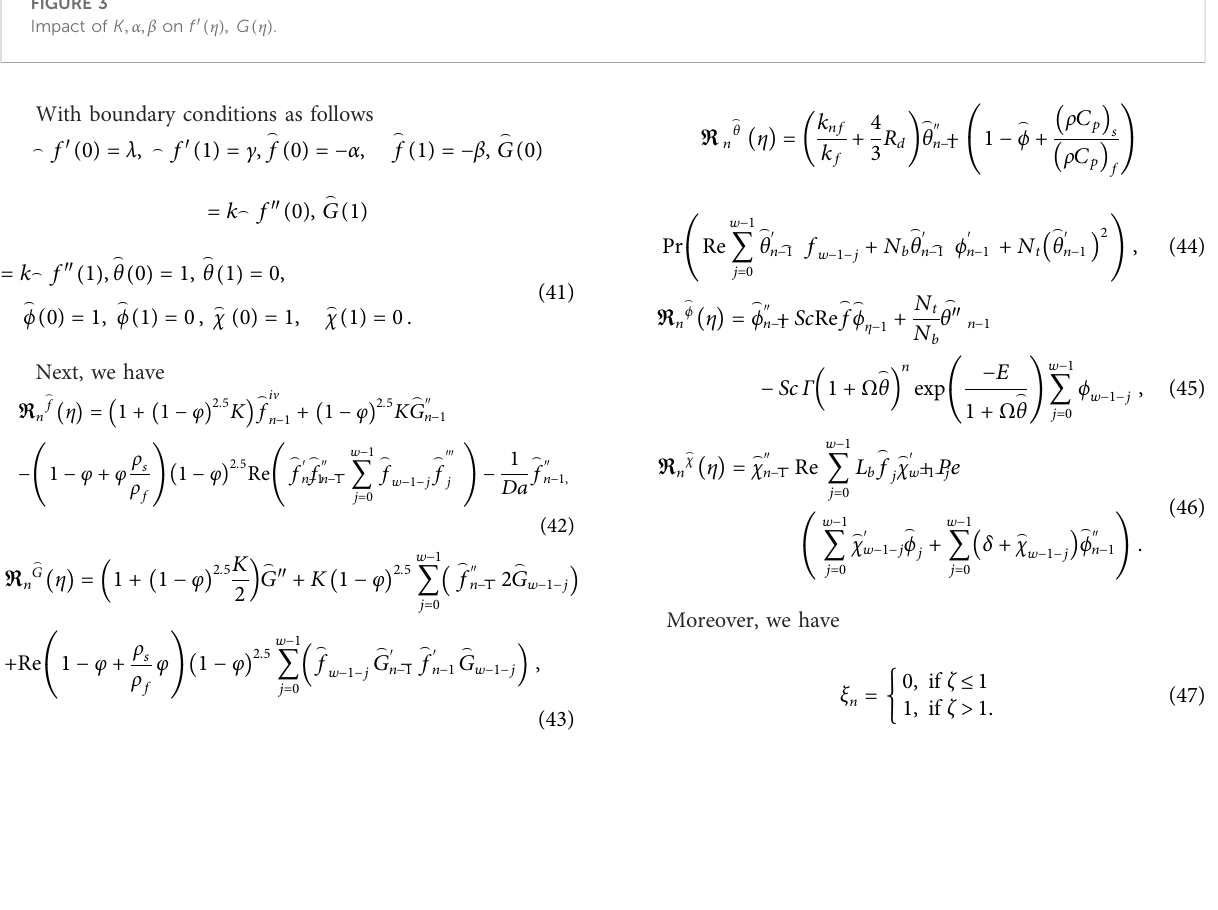
FIGURE 3 Impact of K , α , β on f ′ ( η ) , G ( η )